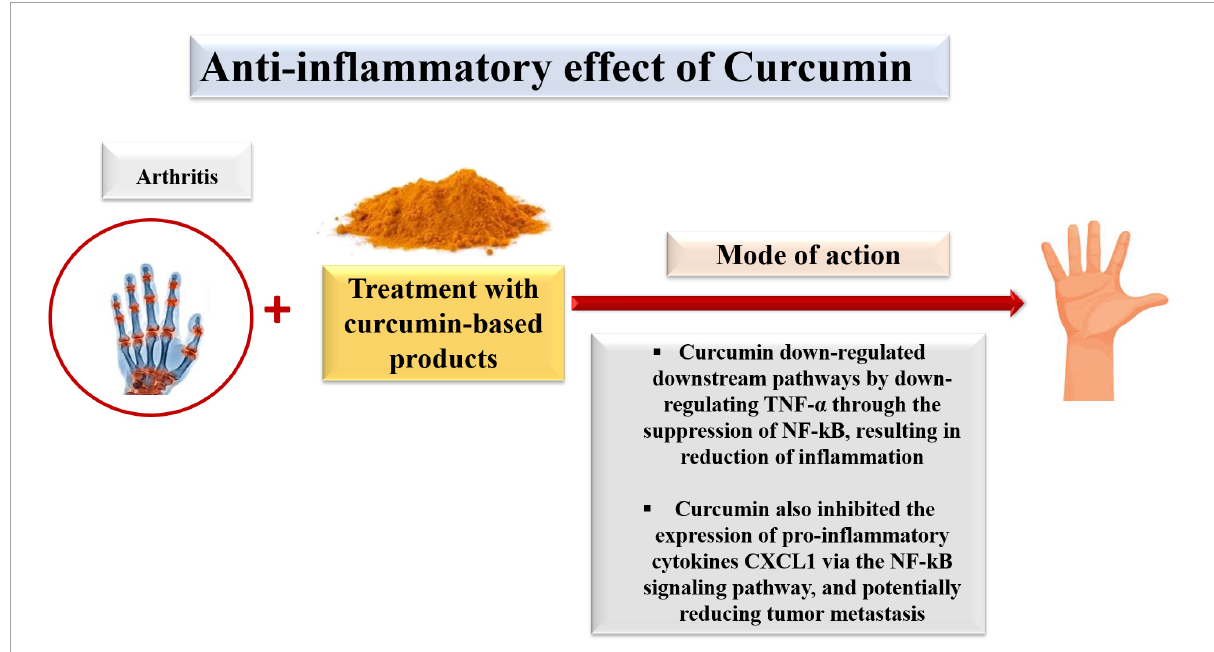
FIGURE7 Anti-inflammatory mechanism of bioavailable